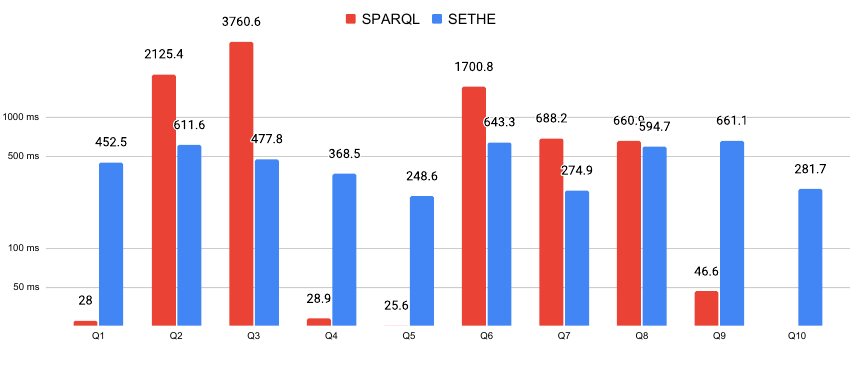
Figure 6. Performance graph.